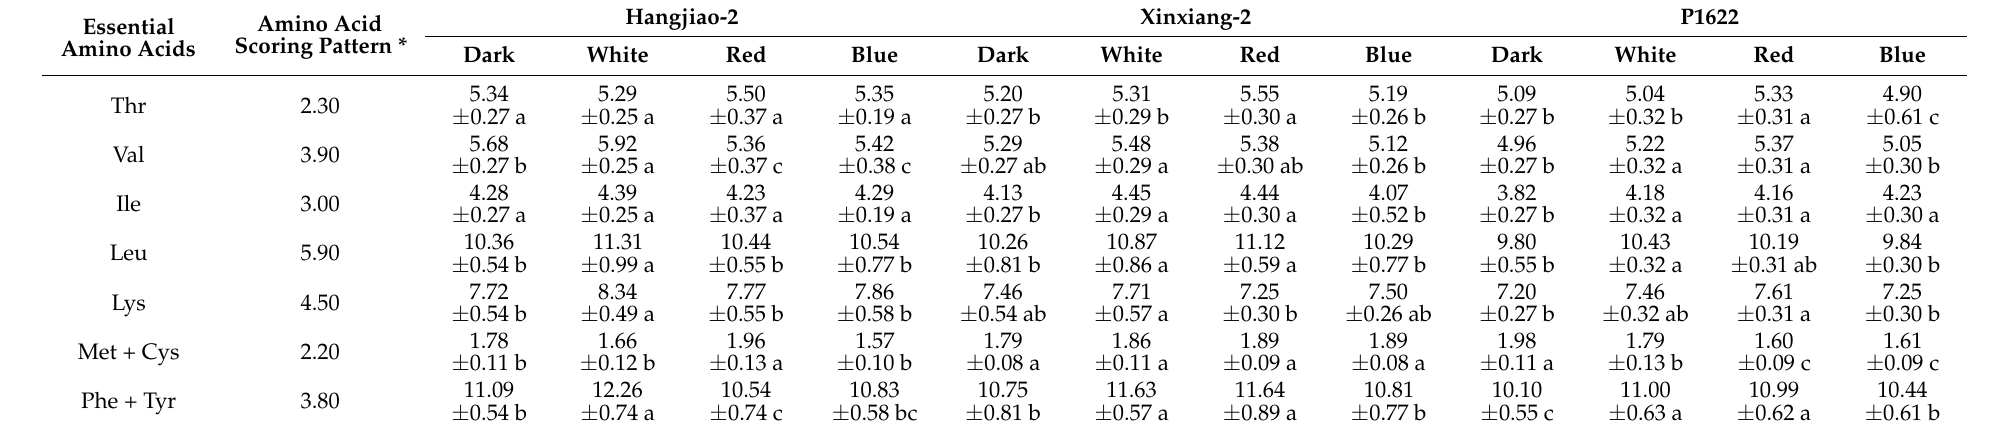
Table 3. Effect of light quality on the essential amino acid score of three pepper cultivars. Essential Amino